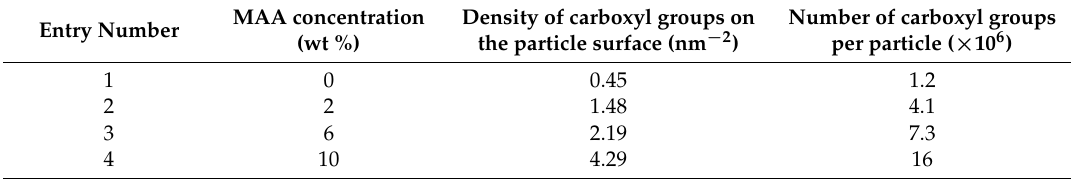
Figure 8. Conductometric titration curves of polymeric microspheres prepared by photoinitiated RAFT dispersion polymerization with different MAA concentrations (0–10 wt %): ( a ) 0 wt %, ( b ) 2 wt %, ( c ) 6 wt %, ( d ) 10 wt %. Table 3. Number of carboxyl groups per particle prepared by photoinitiated RAFT dispersion polymerization of MMA with different MAA